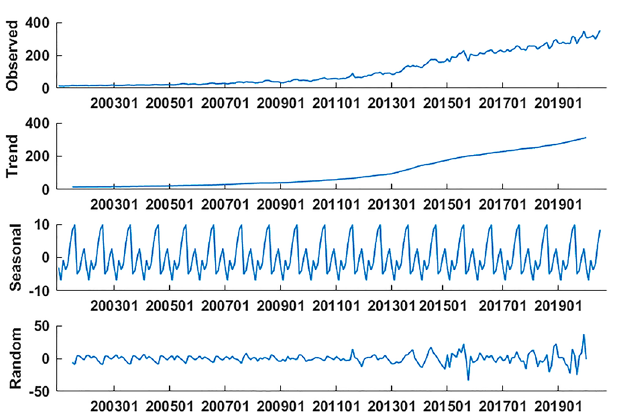
Figure 6. Decomposition of monthly electric energy production time series in Xinjiang from January 2001 to July 2020 (since the x-axis length is limited, only the January location of each year is marked in the figure).